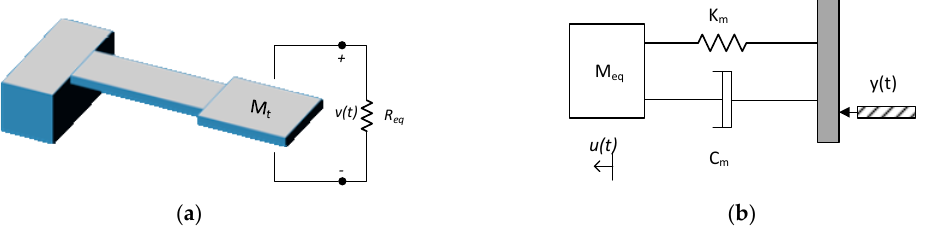
Figure 1. ( a ) Energy harvester; ( b ) mass-spring-damper model.